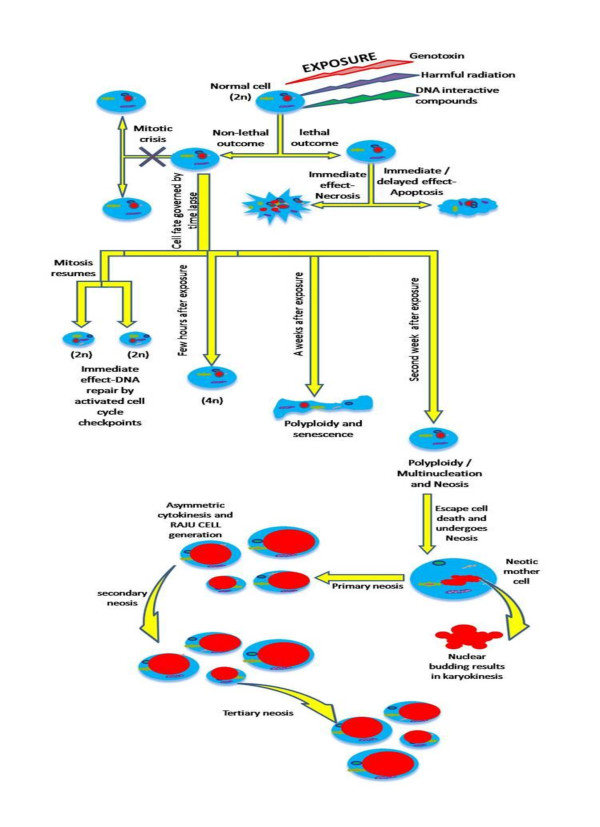
Genes involved in senescence.